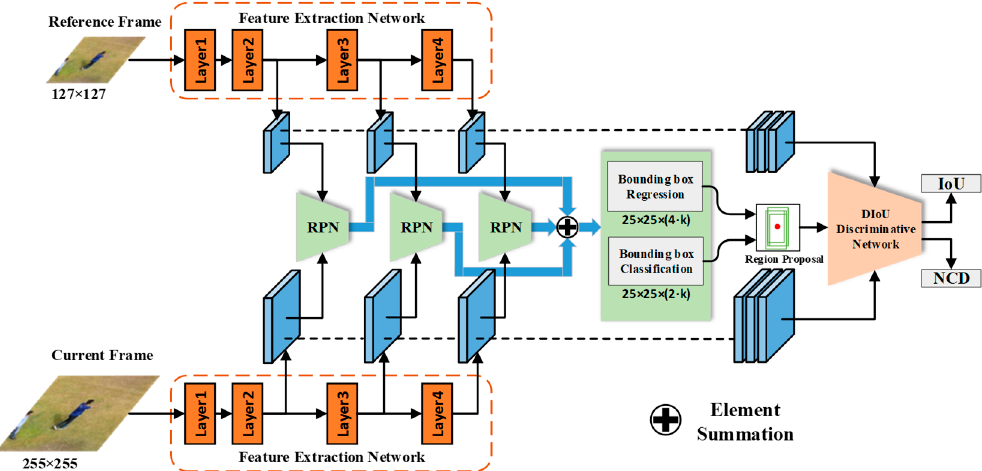
Figure 1. Target tracking framework combining multiple RPNs and DIoU discriminative network. The multiple RPNs are used to determine high-quality candidate regions, and the DIoU discriminative network performs the correction of the candidate regions, and then outputs the final result.